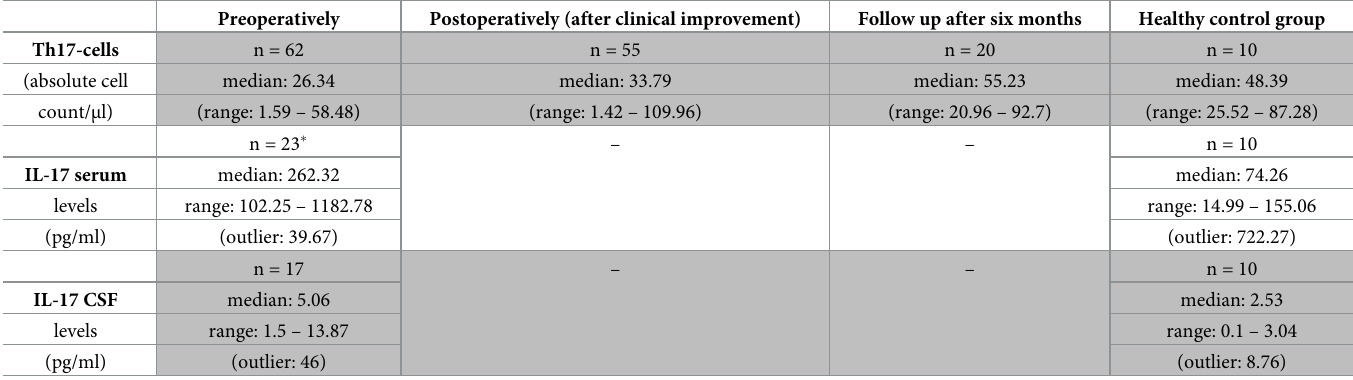
Table 5. Stimulated Th17-cell levels in EDTA-blood, IL-17 concentrations in serum and cerebrospinal fluid (CSF) in dogs suffering from intervertebral disc hernia- tion (IVDH) and in healthy control dogs. Preoperatively Postoperatively (after clinical improvement) Follow up after six